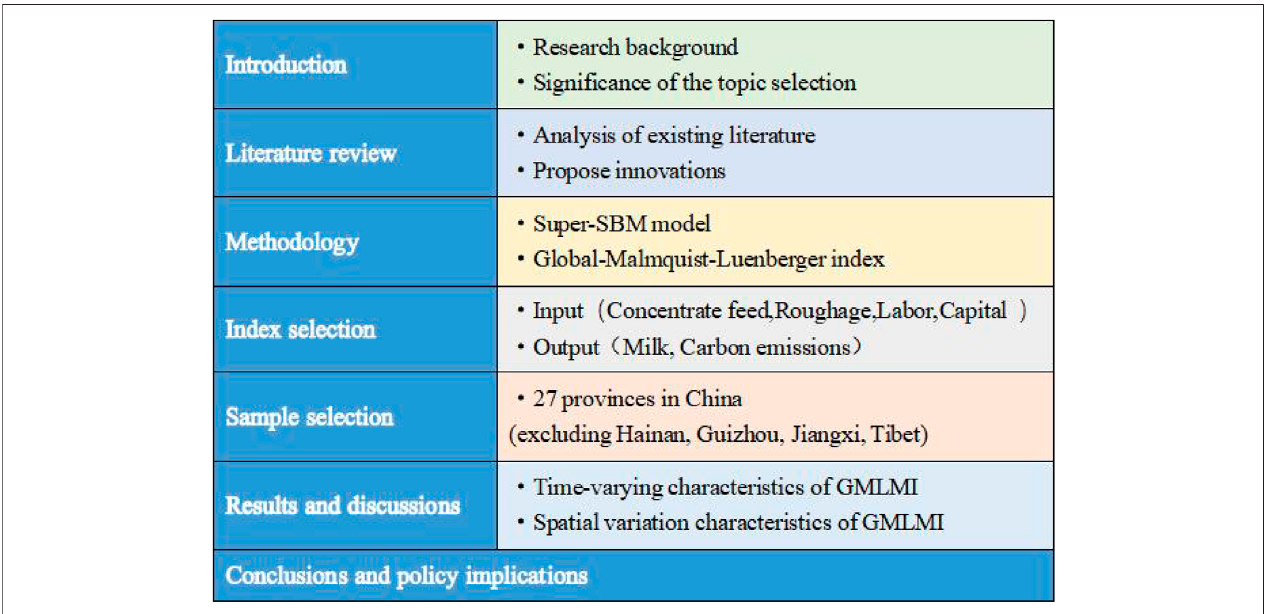
FIGURE 1 | The content framework of the